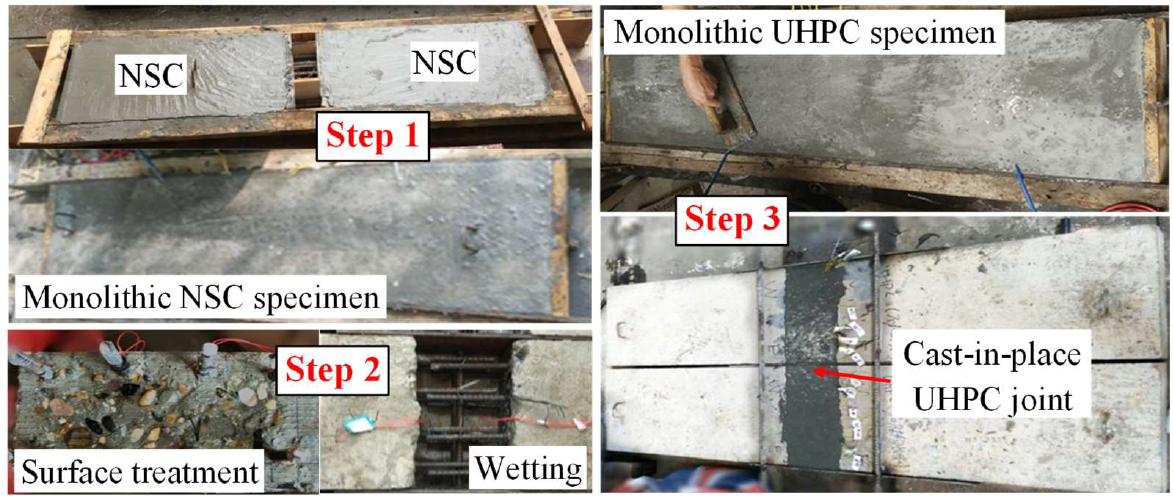
Figure 2. Fabrication of test specimens.